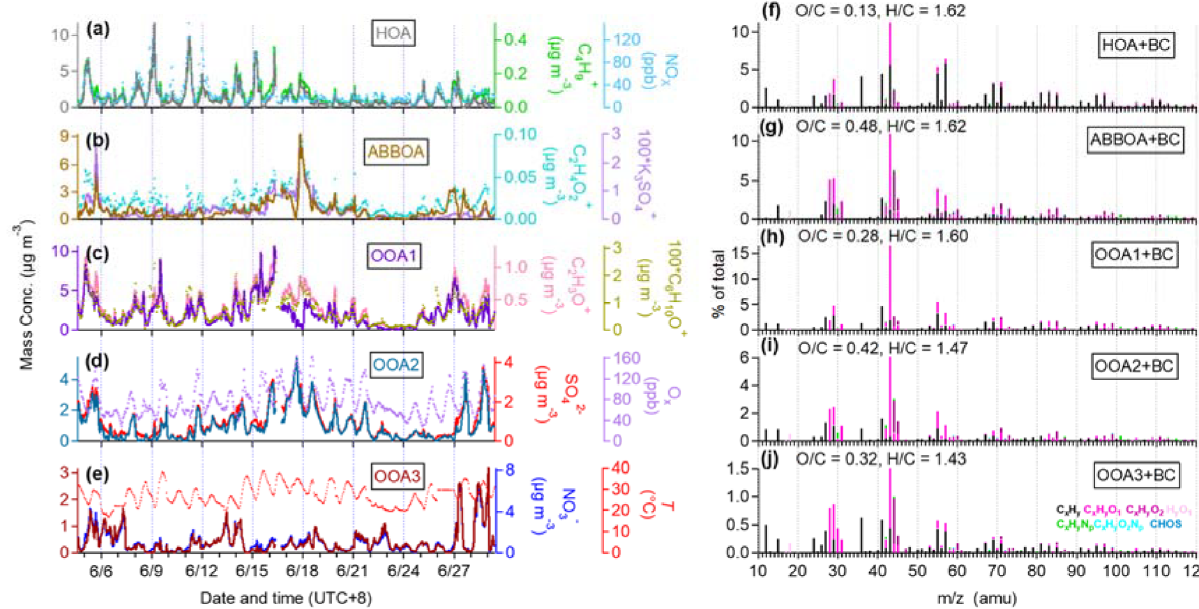
Figure 2. Temporal variations (a–e) and high-resolution mass spectra (f–j) of five OA factors from SP-AMS in summer 2017: (a, f) HOA, (b, g) A-BBOA, (c, h) OOA1 (LO-OOA), (d, i) OOA2, and (e, j) OOA3. Also shown in the left-hand panels are the time series of other tracers, including C 4 H + , NO x , C 2 H 4 O + , K 3 SO + , C 6 H 10 O + , C 2 H 3 O + , SO 2 − , and NO − . 9 2 4 4 3